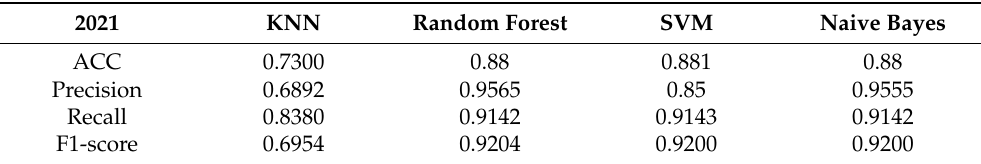
Table 5. Results from complex forecasting models for sequential feature extraction from data for 2021, without feature selection.